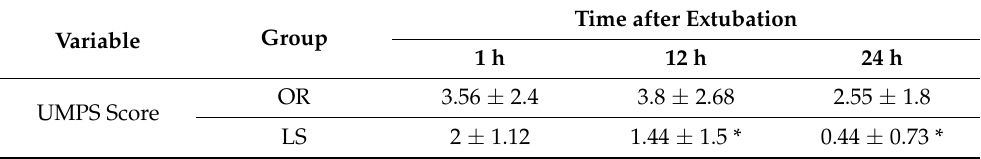
Table 3. UMPS Scores (mean + SD) of dogs that underwent orchiectomy and laparoscopic sterilization.